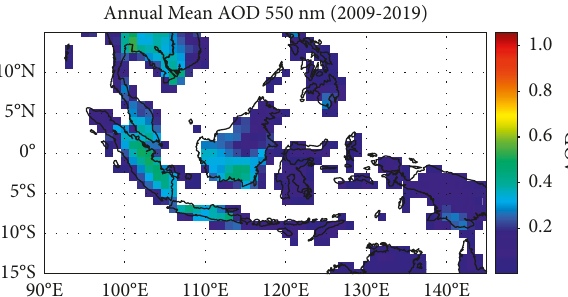
Figure 6: The spatial variation of the annual mean MODIS DB C6.1 AOD at 550nm over land in Indonesia during the period 2009 to